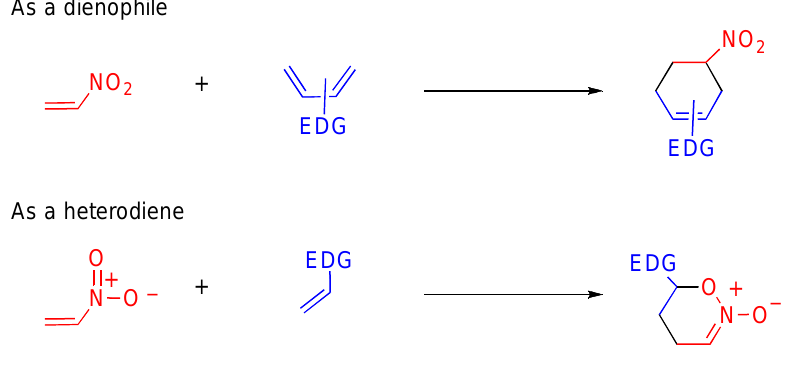
Scheme 18. Diels-Alder reaction of TNQ with